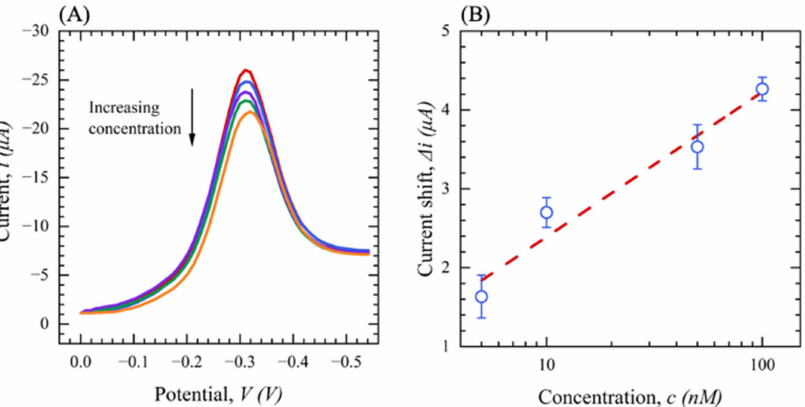
Figure 14. ( A ) SWV for functionalized sensors with different concentrations of SARS-CoV-2 S protein (0–100 nM) in the subject’s filtered saliva (red: filtered saliva (blank), blue: 5 nM, purple: 10 nM, green: 50 nM, orange: 100 nM ( n = 3). ( B ) Current shift ( ∆ i ) as a function of SARS-CoV-2 S protein in subject’s filtered